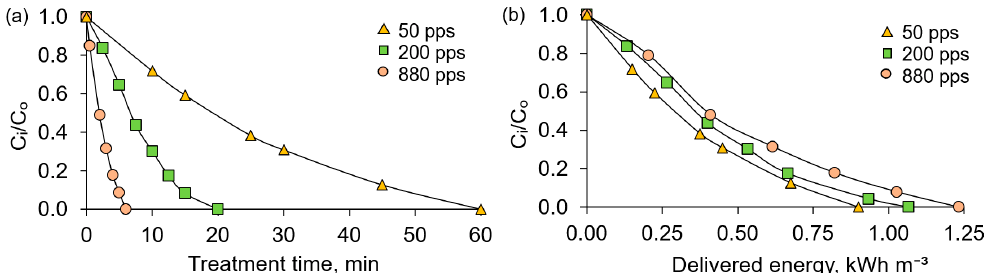
Figure 1. Degradation of aqueous toluene dependent on treatment time ( a ) and delivered energy ( b ) at pulse repetition frequencies of 50, 200, and 880 pps: C 0 = 6.3 mg·L − 1 , initial pH 7.0, 20 °C. Table 1. The second-order kinetic constants and efficiency values of aqueous toluene PCD oxidation. PCD Treatment